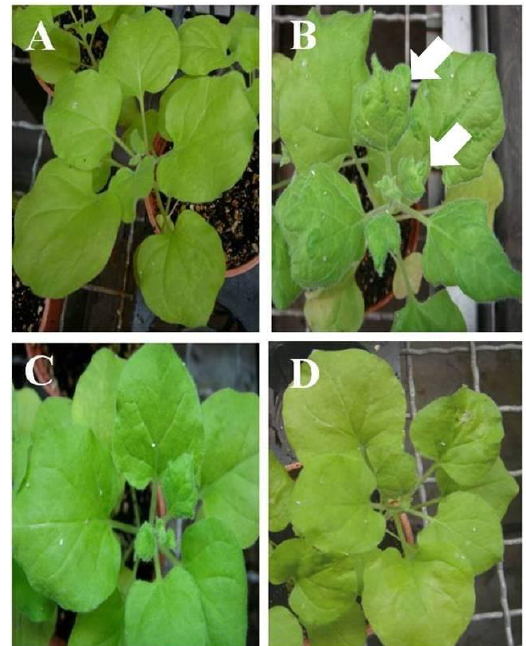
Figure 6. PVY resistance of CmSPI T 1 transgenic N. benthamiana plants at 14 dpi. ( A ) Wild type N. benthamiana -mock; ( B ) Wild type N. benthamiana -PVY inoculated; ( C ) T 1 F-21-2- PVY inoculated; ( D ) T 1 F-51-10- PVY inoculated. Arrow indicates the symptoms of PVY on N. benthamiana .